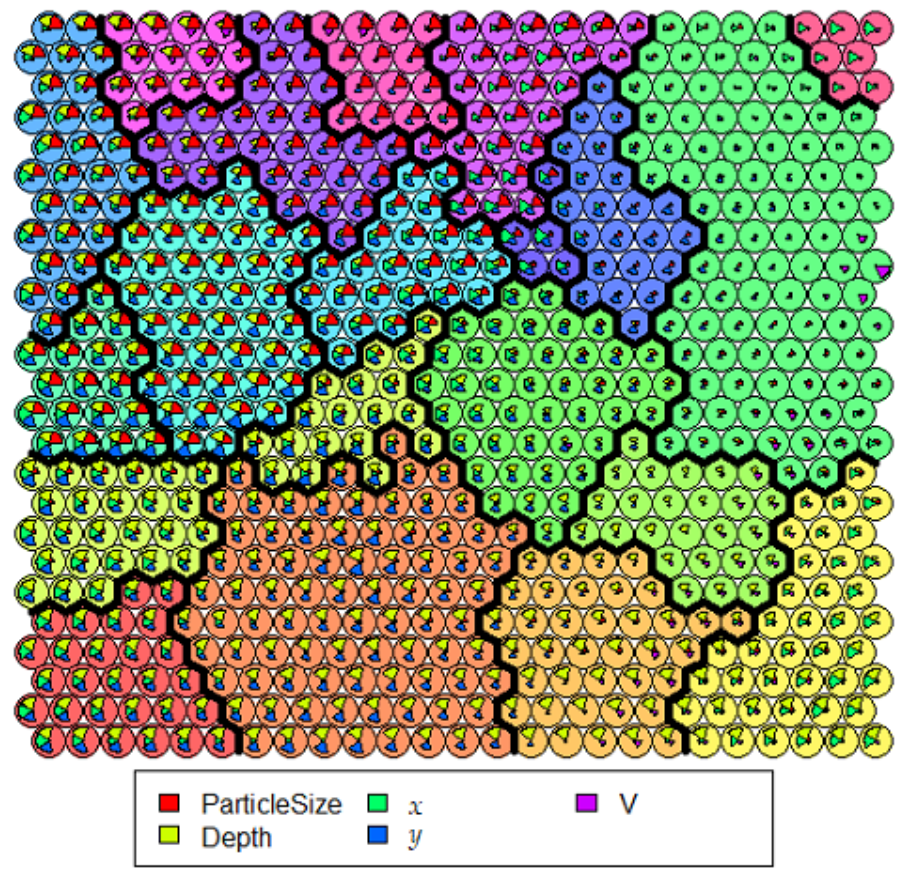
Figure 9. Codes plot of the 25 × 25 Kohonen map.